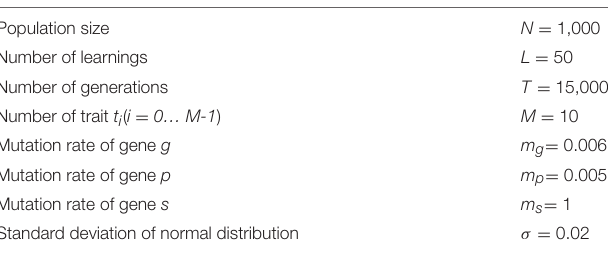
TABLE 3 | Default parameter values.